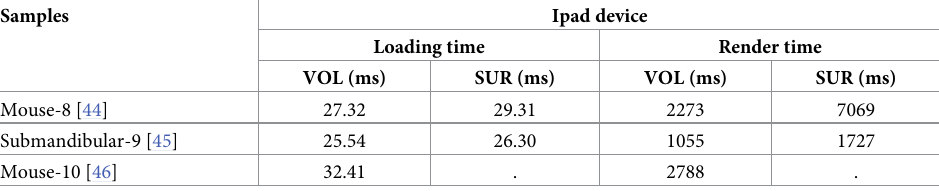
pass the same three data sets from laptop and desktop for comparison purposes, as shown in Table 2. Table 3 shows the time taken by the iPad device to load and render the respective (three-channel mouse proximal colon-8 (147.7 Mb) [44], two-channel submandibular gan- glion-9 (68.2 Mb) [45], and two-channel mouse proximal colon-10 (297.8 Mb) [46]) image data in a Google Chrome web browser. For the three-channel mouse proximal colon-8 [44] data, the iPad device took 2273 and 7069 ms to render it into volume and surface, as shown in Table 3, which are high compared to laptop and desktop performance for the same input (as shown in Table 2). Moreover, in the case of two-channel submandibular ganglion-9 (68.2 Mb) [45], a similar pattern can be noticed; the iPad device requires more computing power to render them into volume and sur- face than the other two devices. Furthermore, in the case of volume rendering for the two- channel mouse proximal colon-10 (297.8 Mb) [46], iPad device took 2788 ms, which is again excessive when compared to laptop (2086.6 ms) and desktop (2275.75 ms) devices. When the Table 3. 3D viewer performance measurement on Ipad device. Samples